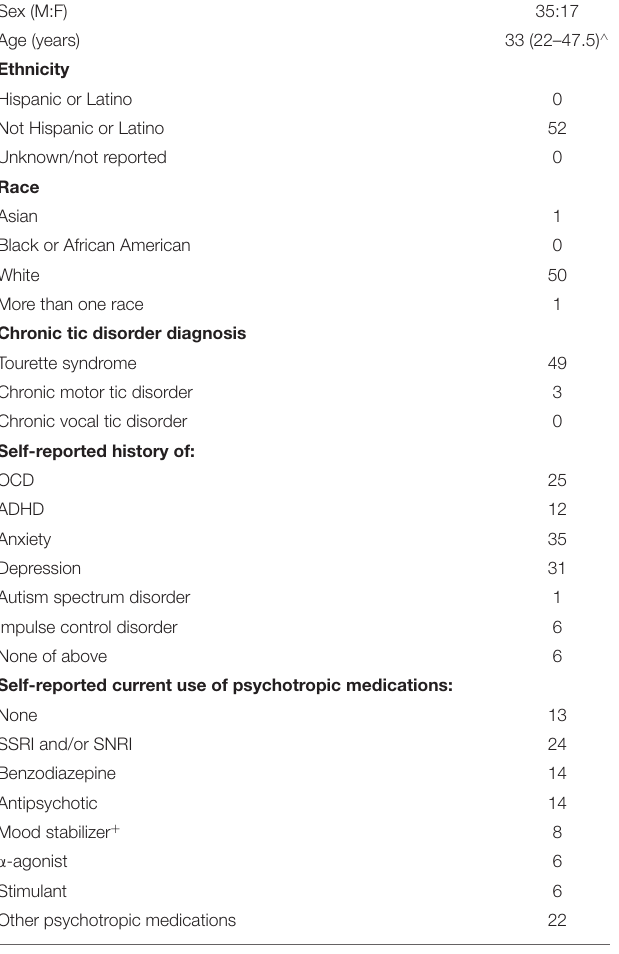
TABLE 4 | Spearman rank correlation